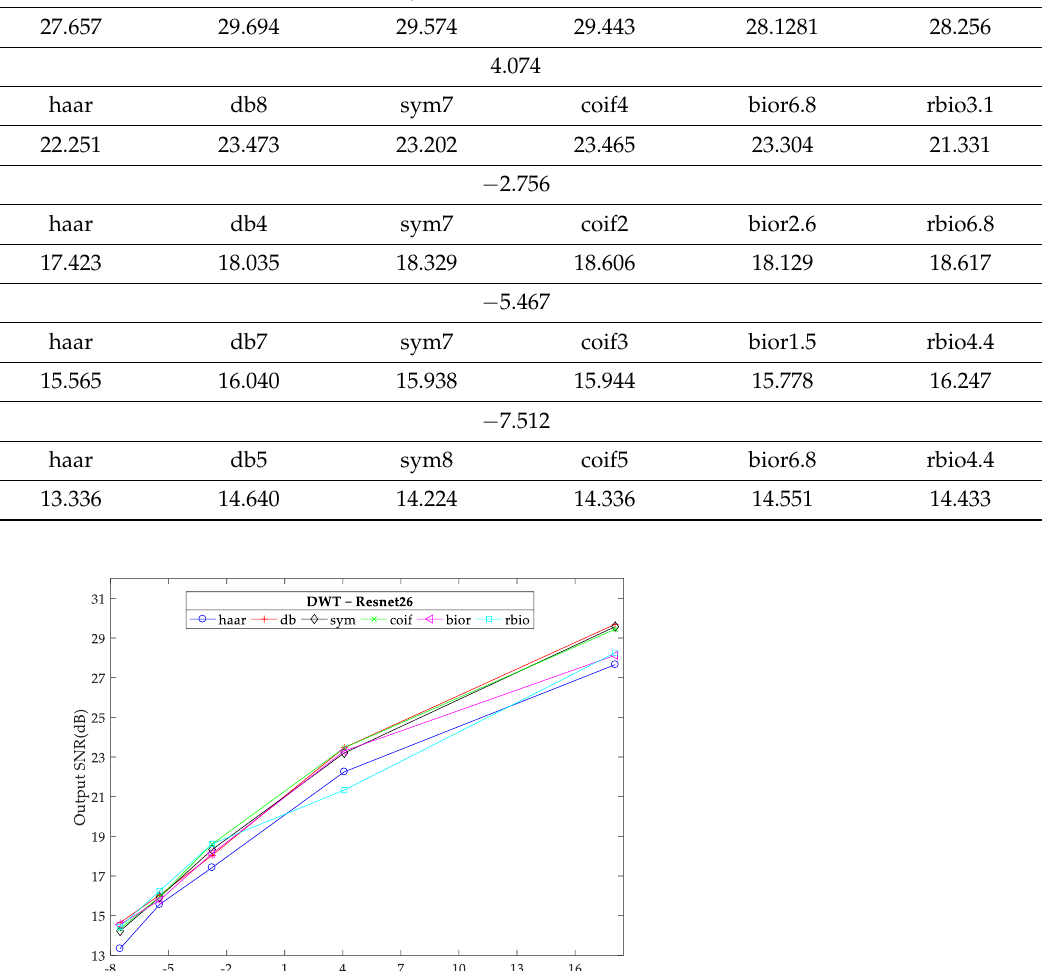
Table 2. DWT − Resnet26 denoising results obtained by using different wavelet bases for seismic data with different SNRs.